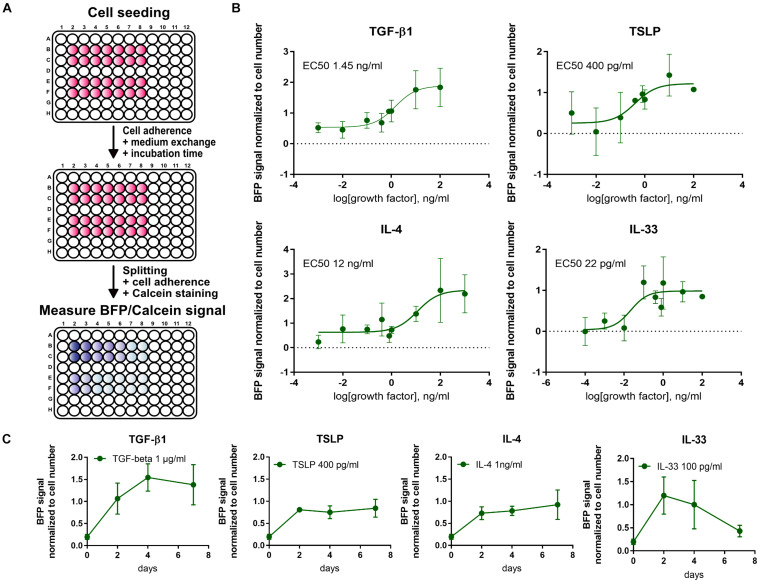
High-throughput screening using the 10-4ABFP cell line. (A) Schematic of plate reader assay to study the fibrotic response of 10-4ABFP to cytokine treatment in live cell assays. For normalization to the cell number, cells were stained with Calcein AM. (B) Dose-response curves of BFP expression in 10-4ABFP cells in response to 2 days exposure with increasing doses of TGF-β1, TSLP, IL-4, and IL-33. (C) Time-response curve of 10-4ABFP cells to continuous exposure to TGF-β1, TSLP, IL-4, and IL-33.